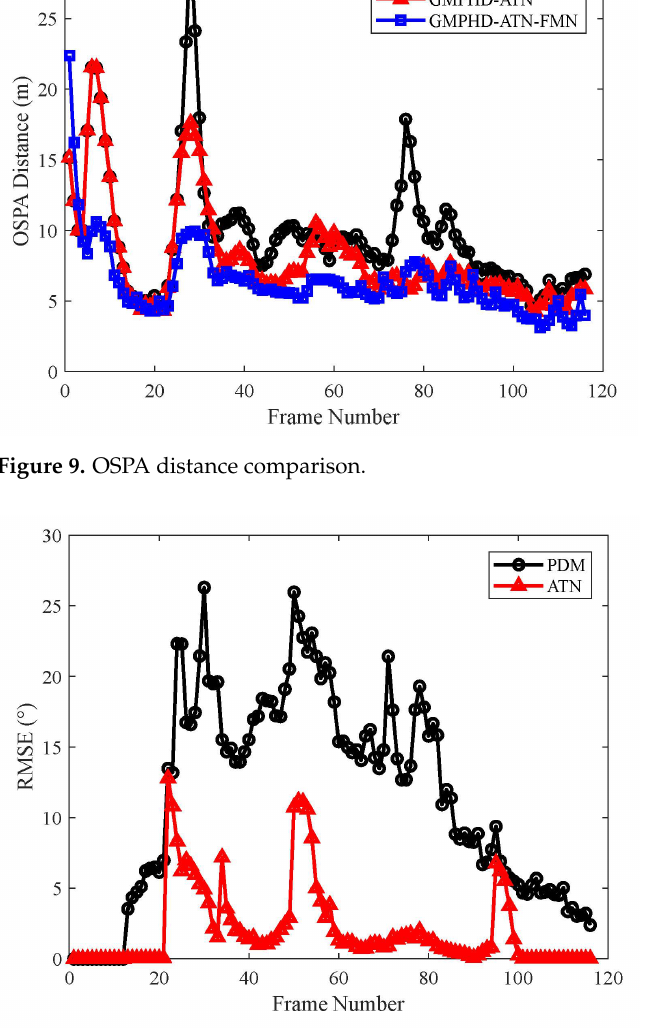
Figure 10. RMSE of turn rate